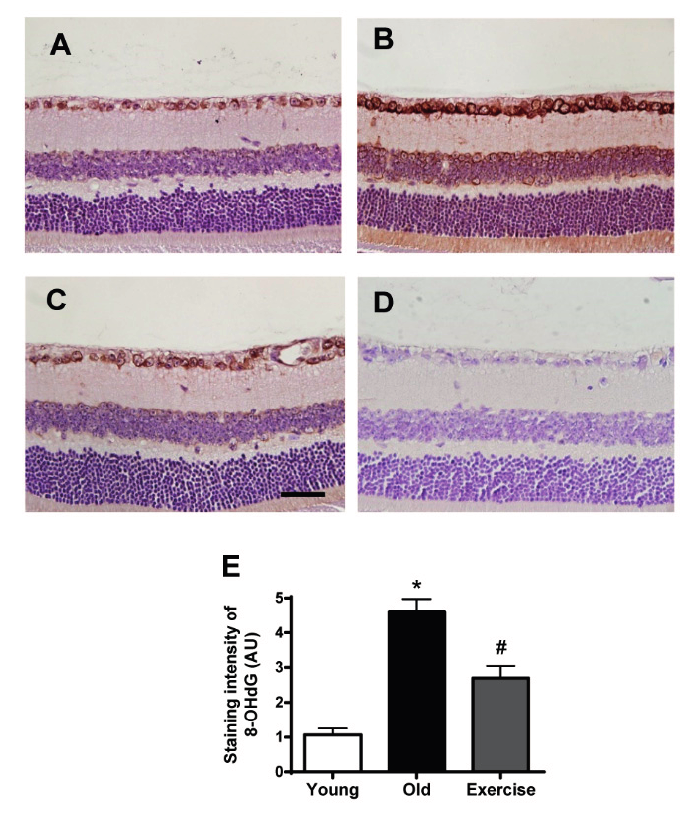
Figure 3. Retinal 8-hydroxy-2 ′ -deoxyguanosine (8-OHdG) formation. Immunohistochemical staining for 8-OHdG, an oxidative DNA damage marker, was performed on the retinas from the young control ( A ); old control ( B ); exercise ( C ) groups; and ( D ) negative control. The primary antibody was omitted. Scale bar = 50 μ m. 8-OHdG immunoreactivity was weakly detected in the ganglion cell layer of the young control mice, whereas 8-OHdG-positive signals were observed in the nuclei of the ganglion cell layer and the inner nuclear layer in the old control mice. However, exercise reduced 8-OHdG formation in retinal tissues; and ( E ) the values in the bar graphs represent the means ± SE, n = 8. * p < 0.05 vs . the young control group; # p < 0.05 vs. the old control